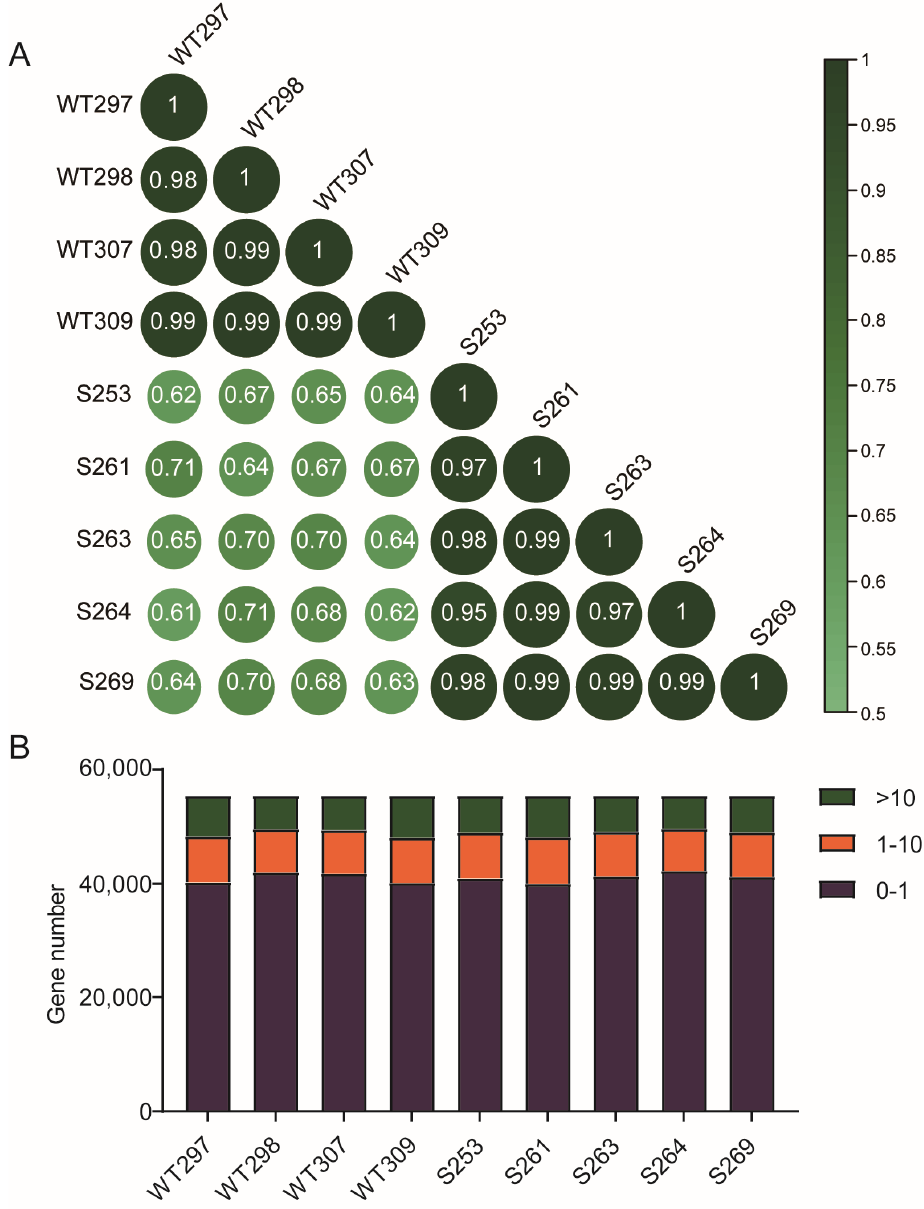
Figure 5. Description of RNA-sequencing of all muscle samples from WT and Zbed6 +/ − mice. ( A ) The correlation analysis of WT and Zbed6 +/ − groups. The larger the value is, the stronger the correlation is. ( B ) The statistic chart of TPM value of all skeletal muscle samples.